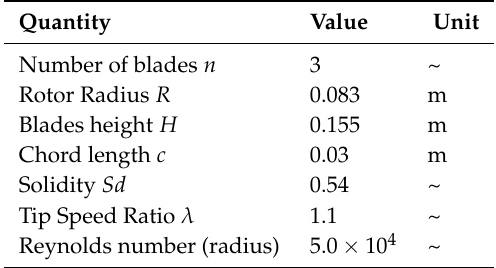
Table 1. Rotor configuration from Rolin and Porté-Agel